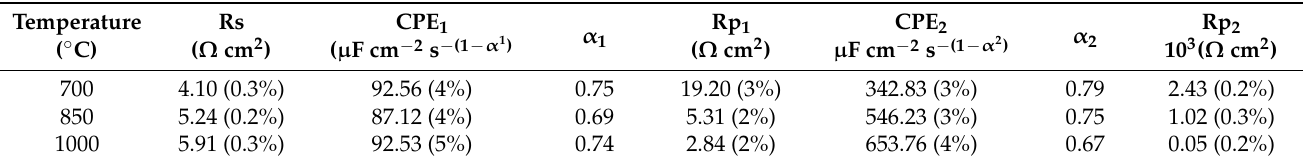
Values of the electrochemical parameters of the equivalent electrical circuit for Bi 3.75 La 0.25 Ti 3 O 12